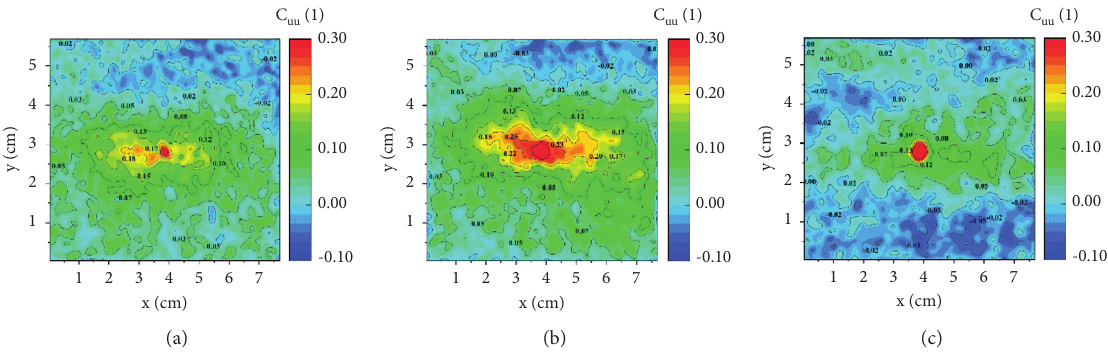
Figure 7: The distribution of C uu in different working conditions. (a) B25S. (b) B25M. (c) B25L.